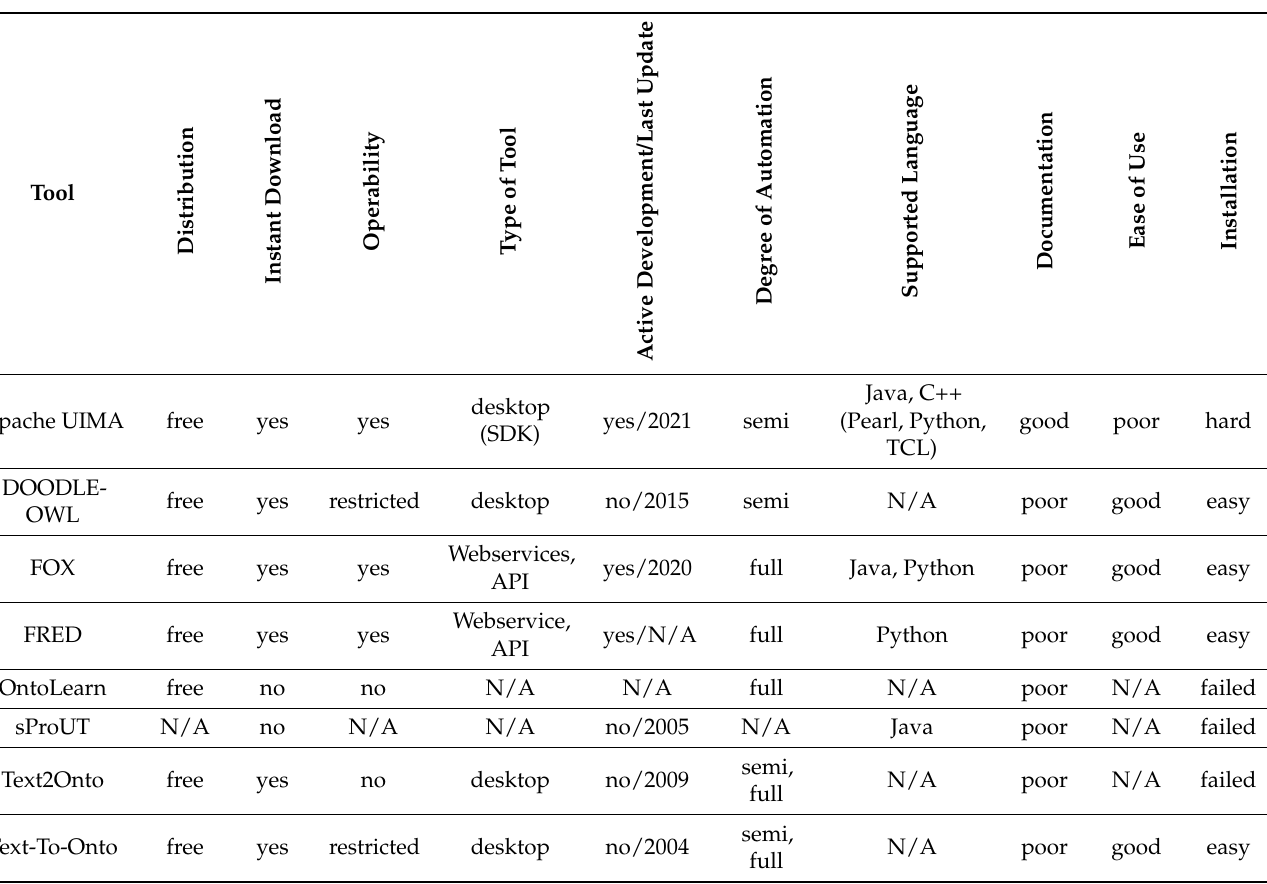
Table 6. Main features of the